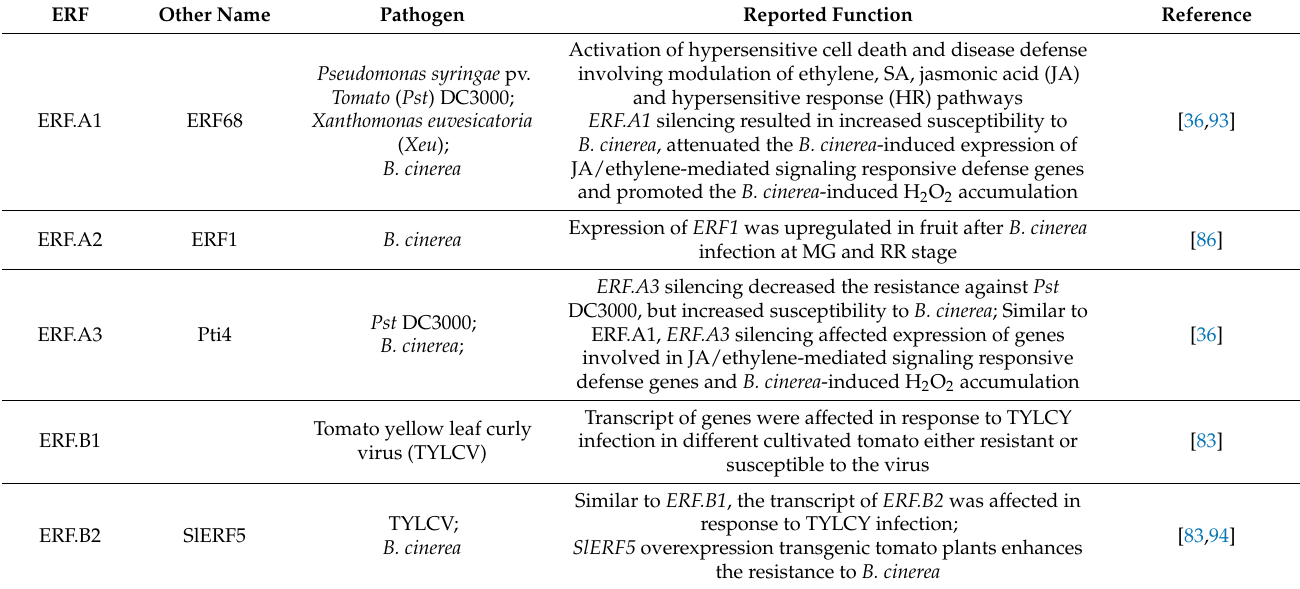
Table 1. ERFs involved in pathogenic response of